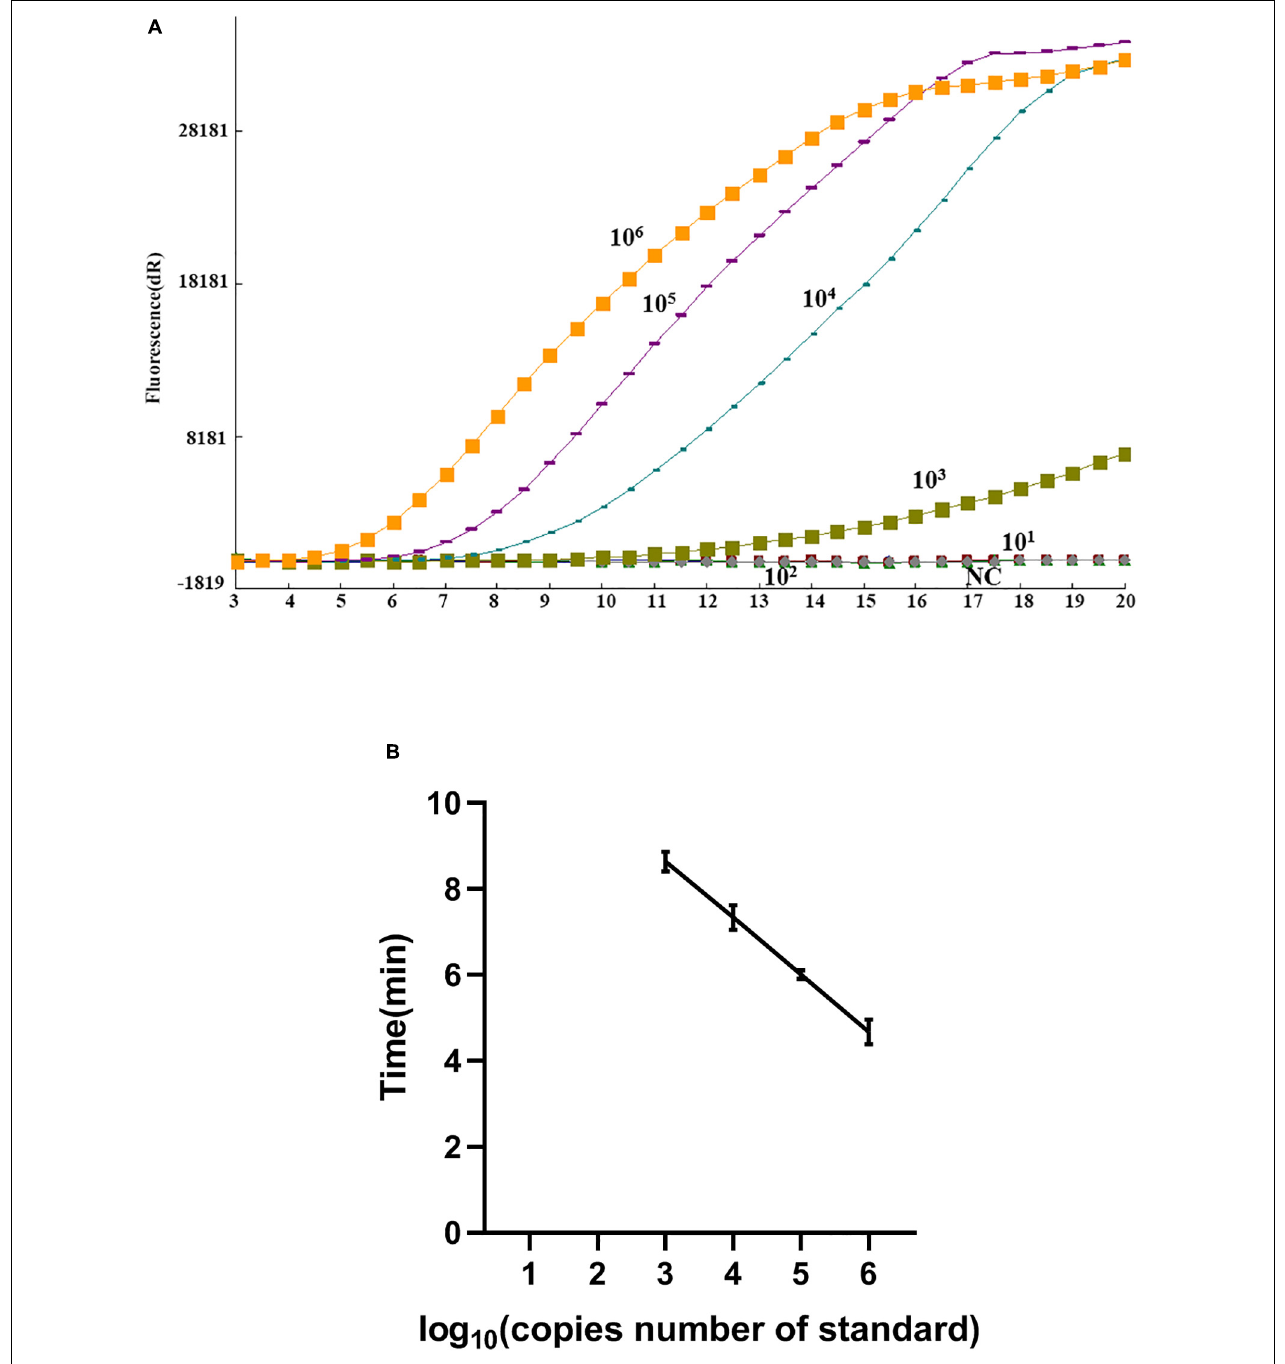
FIGURE 2 | Sensitivity of the real-time recombinase-aid amplification (RAA) assay. (A) Amplification curve of the real-time RAA assay over time using a dilution range of 10 6 –10 1 copies/reaction of pASFV/RAA. (B) Reproducibility of the real-time RAA assay. The threshold time is represented as the mean ± standard deviation (SD). The standard regression line was generated based on three datasets. NC , negative